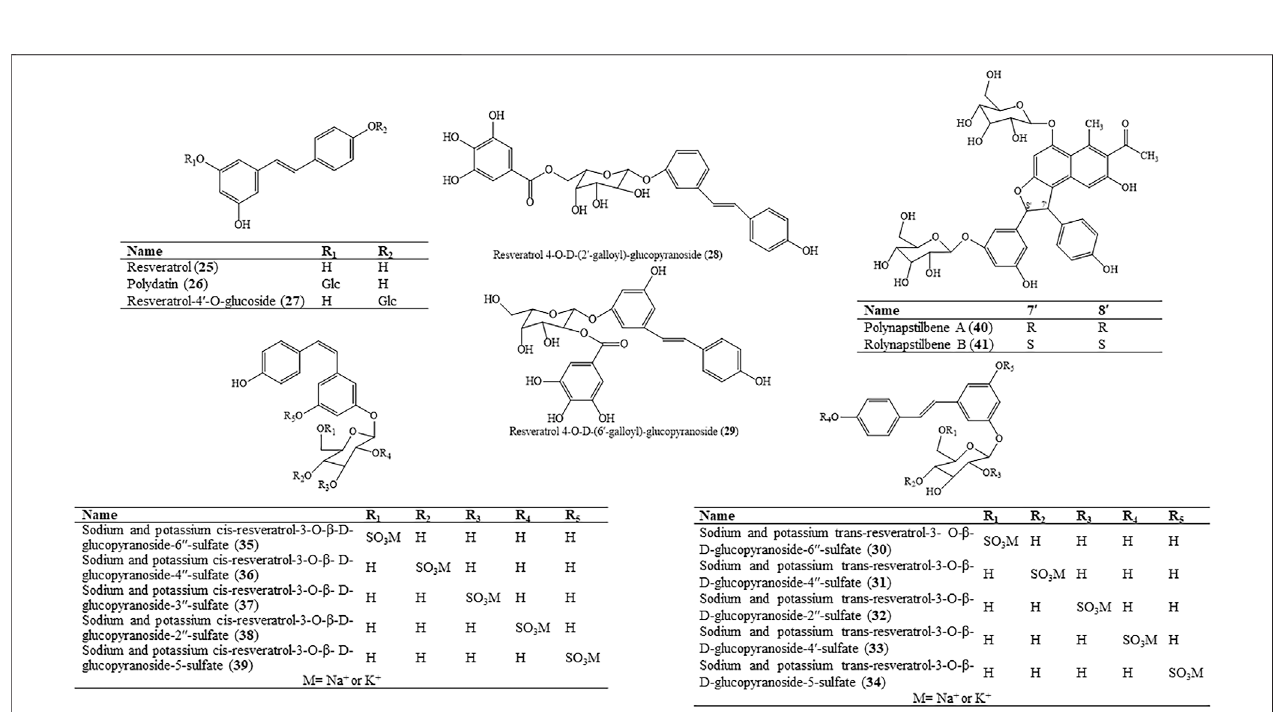
FIGURE 3 | Molecular structure of quinones (A) . Anthraquinones; (B) . Naphthoquinones in HZ.